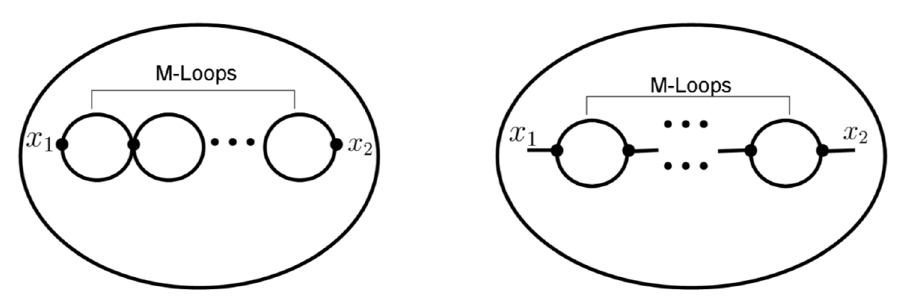
Figure 16 . The diagrams which we consider in section 7. Left: (cid:30) 4 theory: The 2-point bulk-to- bulk correlator consisting of a sequence of M -bubbles. Right: (cid:30) 3 theory: The 2-point bulk-to-bulk correlator consisting of a sequence of M